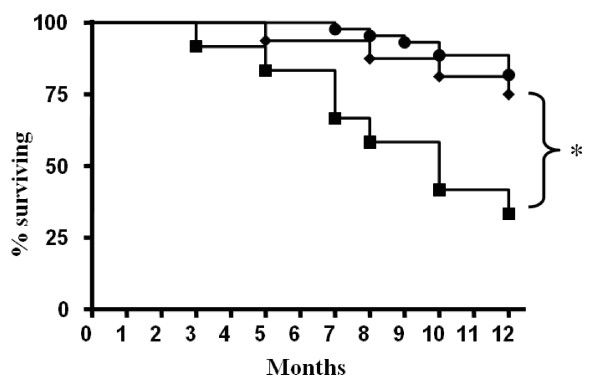
Kaplan-Meier plots of survival in 72 patients affected by amyotrophic lateral sclerosis (ALS) from the initiation of NPPV. (Black circle) = 44 patients with ALS with FVC > 75%, (Black triangle) = 16 patients with ALS with FVC < 75% treated with NPPV, (Black square) = 12 patients with ALS with FVC < 75% not treated with NPPV. ALS patients with FVC < 75% treated with NPPV vs. patients with ALS with FVC < 75% intolerant to NPPV: χ2 5.32; *p = 0.02. Patients with ALS with FVC > 75% vs. patients with ALS with FVC < 75% treated with NPPV: χ2 = 0.408 p = 0.5. Patients with ALS with FVC > 75% vs. patients with ALS with FVC < 75% not treated with NPPV: χ2 = 15.4; p < 0.0001.